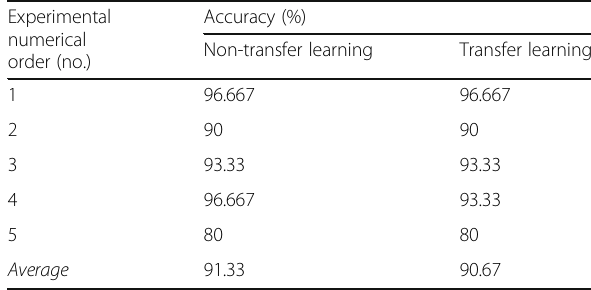
Table 3 The continuous five times classification